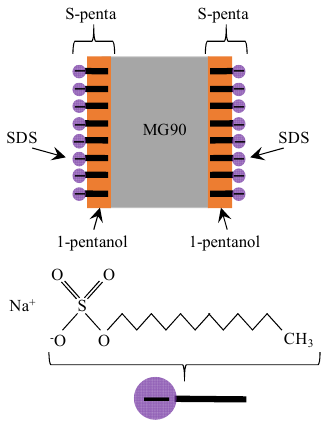
Figure 4. Side view of SMG90 and the structure of SDS. Figure. 4. Side view of SMG90 and the structure of SDS. Figure. 4. Side view of SMG90 and the structure of SDS.